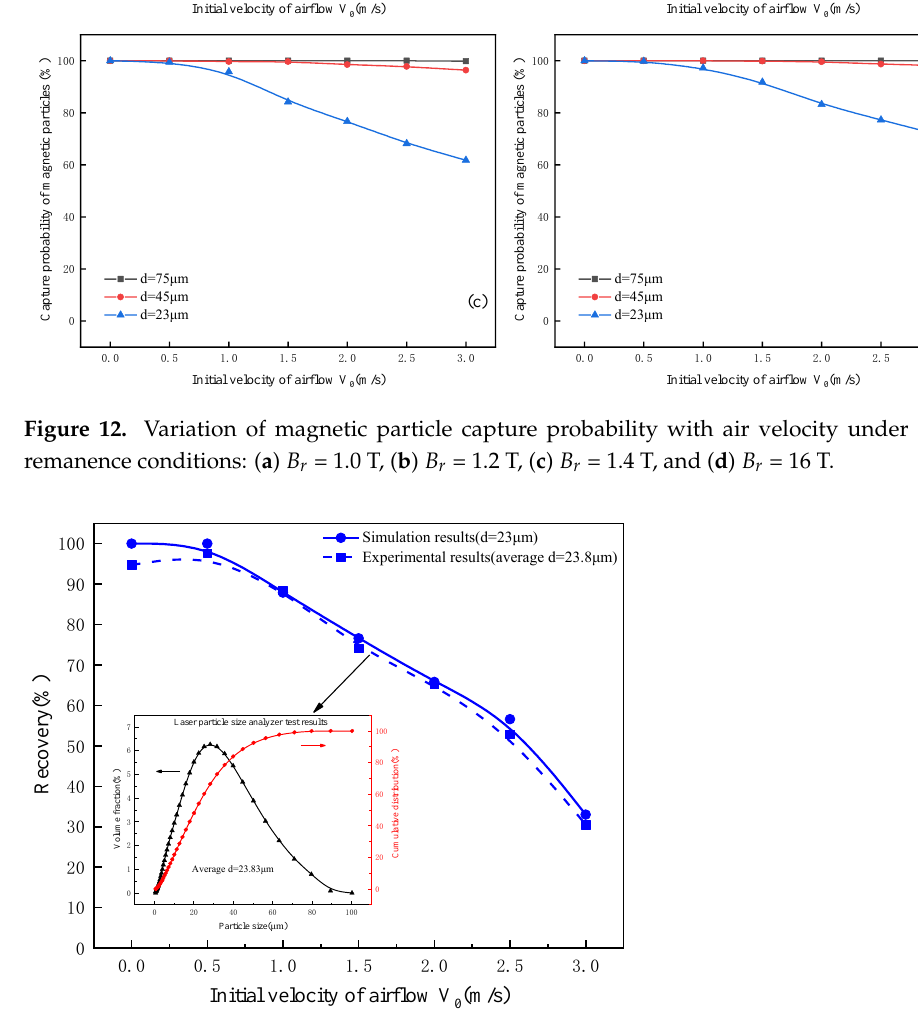
Figure 13. Comparison of magnetite verification experiment results and simulation results.